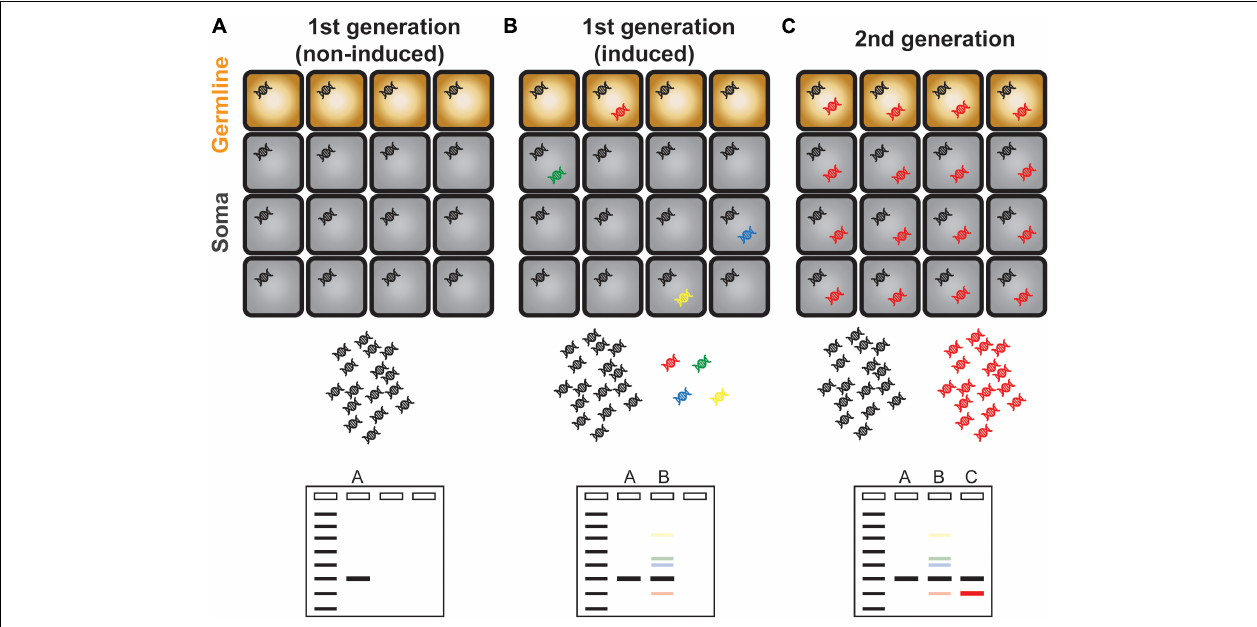
FIGURE 1 | Schematic illustration of transposon display. (A) A single copy TE is present evenly in all cells and is represented as a single band in a transposon display experiment. (B) Activation and mobilization of a TE gave rise to new and additional copies inserted in different genomic positions as represented in different colors. Because of the scarcity of newly copied DNA, transposon display method is unable to amplify these DNAs which are illustrated as faint bands. (C) The new TE copy that mobilized in germline cells is inherited to the next generation. The transgenerationally maintained new TE DNA can be amplified efficiently and is visible as a discrete band in a gel